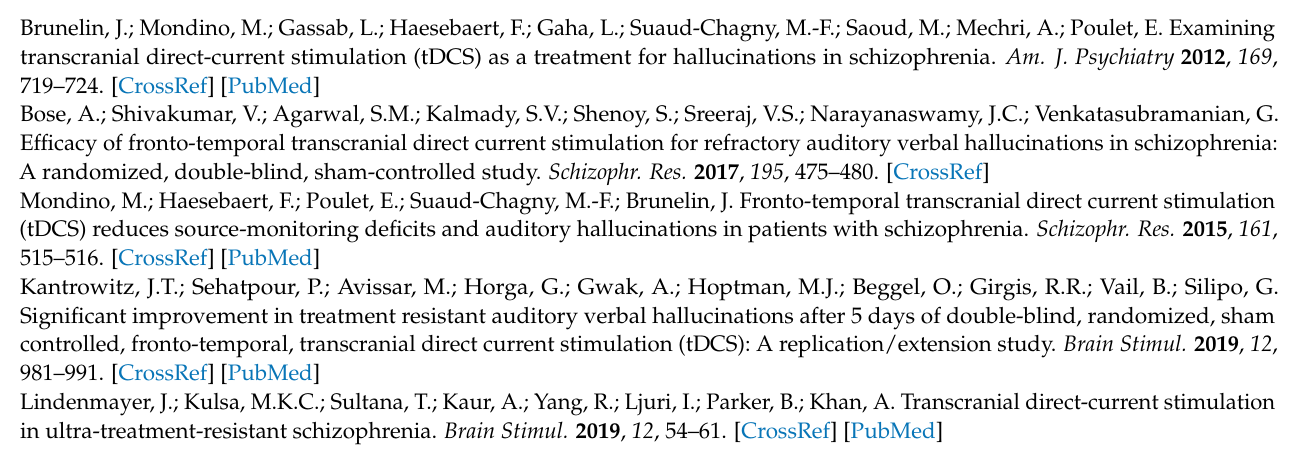
results; Figure S5: T-contrasts for dichotic listening paradigm; Figure S6: Electrical field simulation of tDCS for all participants in the real tDCS and sham tDCS groups; Table S2: Descriptive means for Glx and GABA by real and sham group (values in institutional units); Table S3: Frequency of adverse events as measured with the tDCS Adverse Effects Questionnaire in number of occurrences in all real and sham tDCS sessions (n =